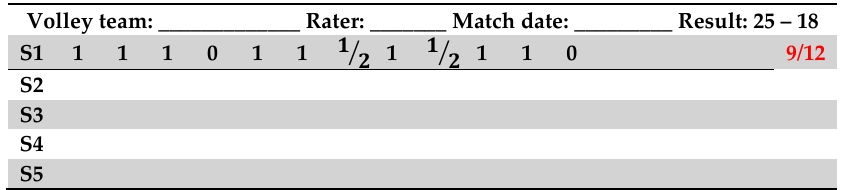
Figure 1. A prototype of observers’ grid. Table 1. Attribution criteria for the raw individual score calculation.